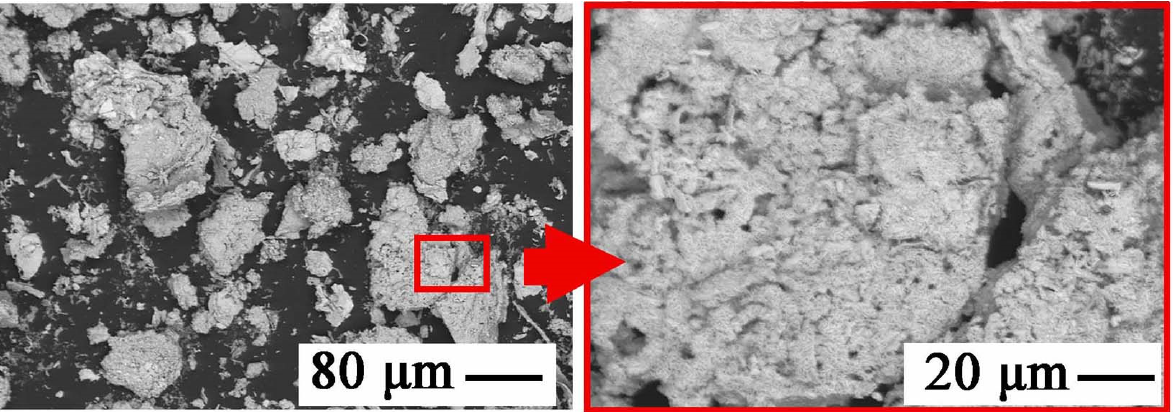
Figure 15. SEM image of the precipitated phase during the selective recycling of black mass from a battery with NaOH as a precipitant at pH 6.5. Table 6. Conditions of pH and amount of NaOH during precipitation of zinc and manganese from solution after non-selective